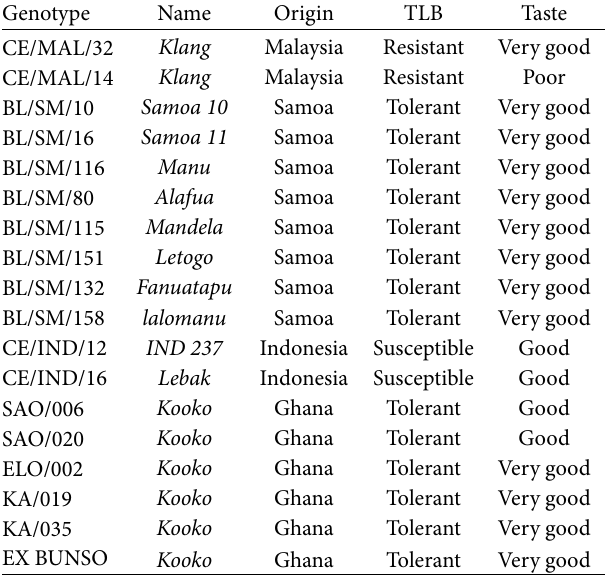
Table 1: Source of taro genotypes used for the